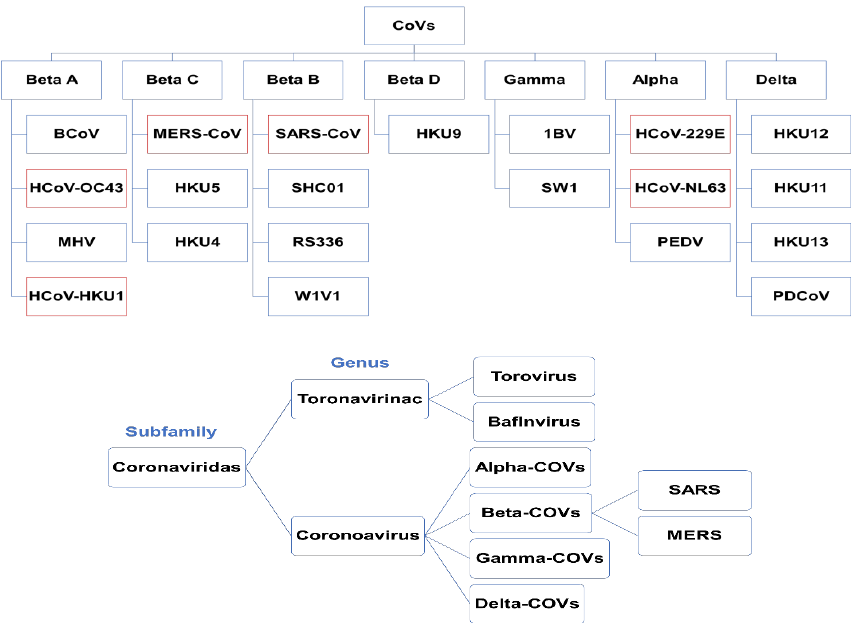
Figure 2. Classification of human coronaviruses (HCoVs) from all four gen-groups. HCoVs are marked with red outlines. Adapted from Monajjemi et al. [61], licensed CC BY 4.0.